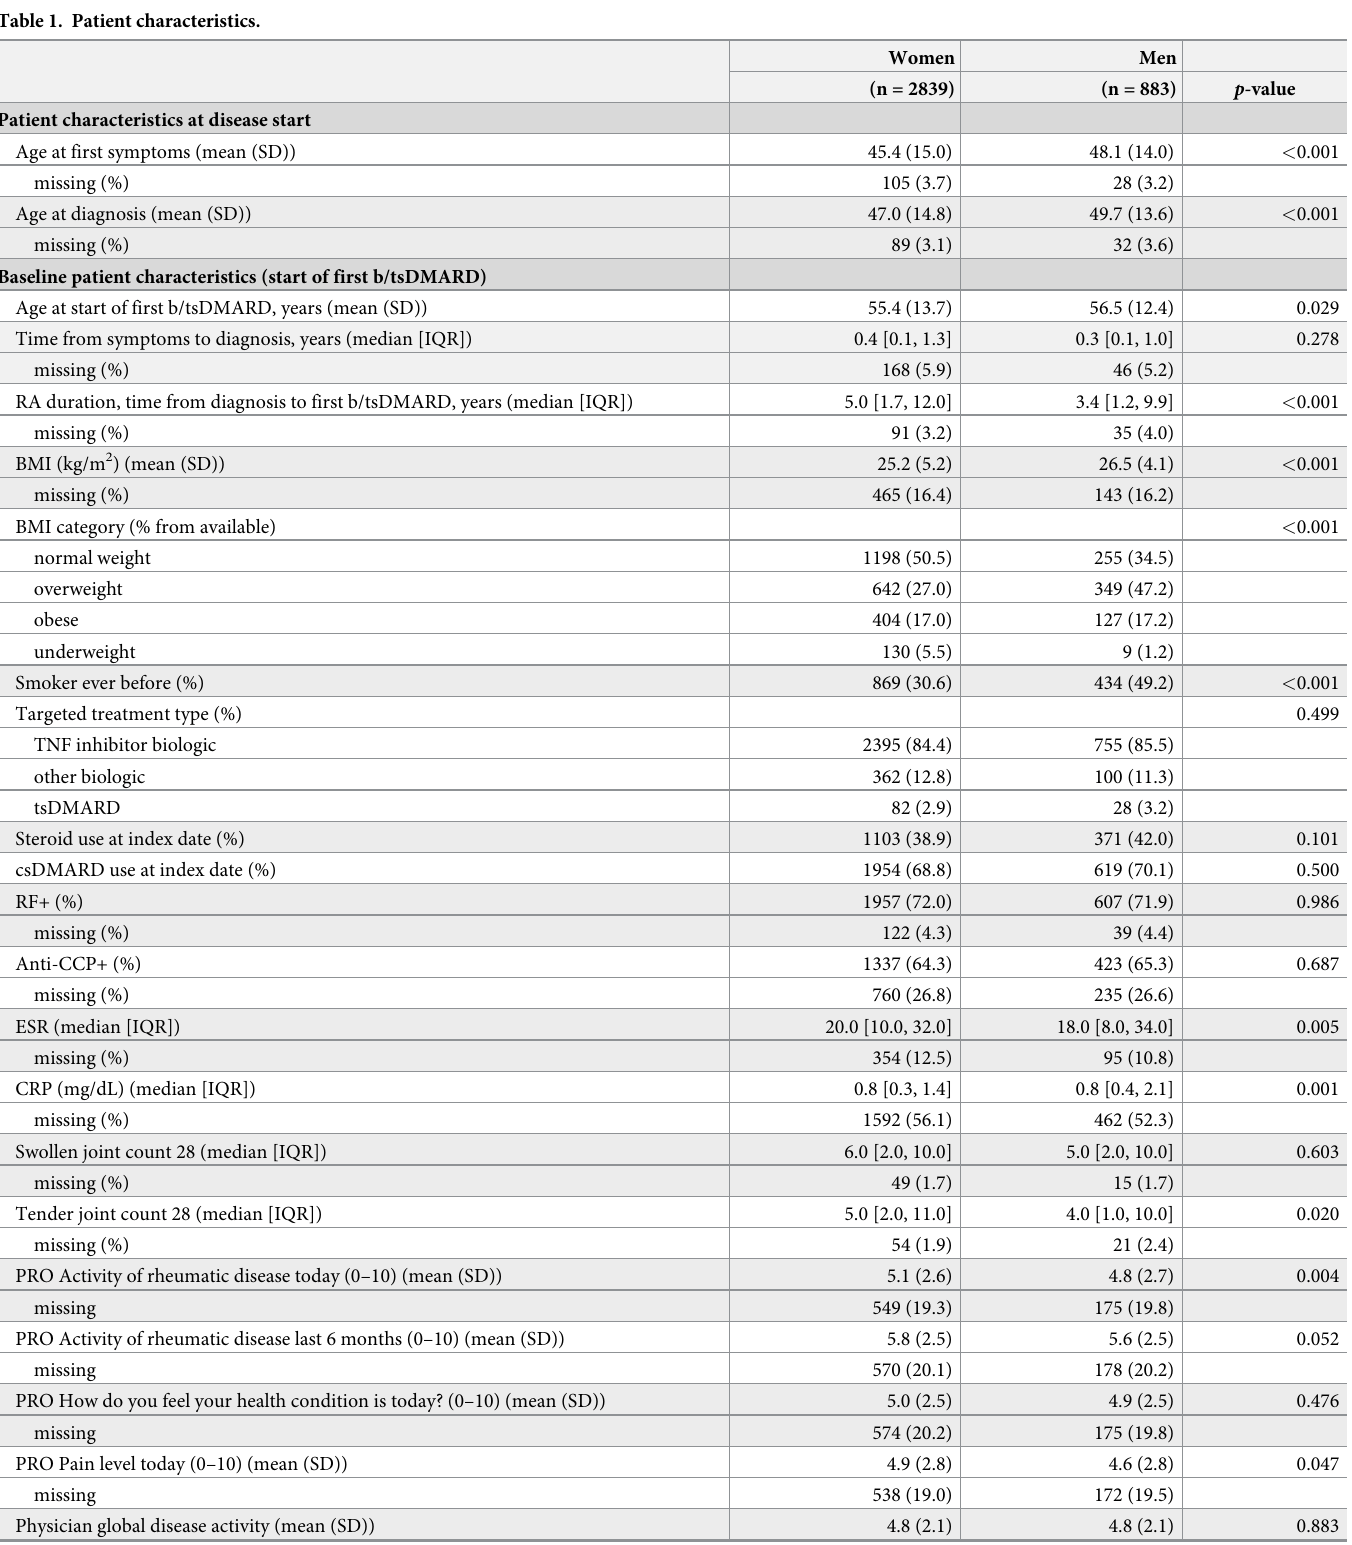
Table 1. Patient